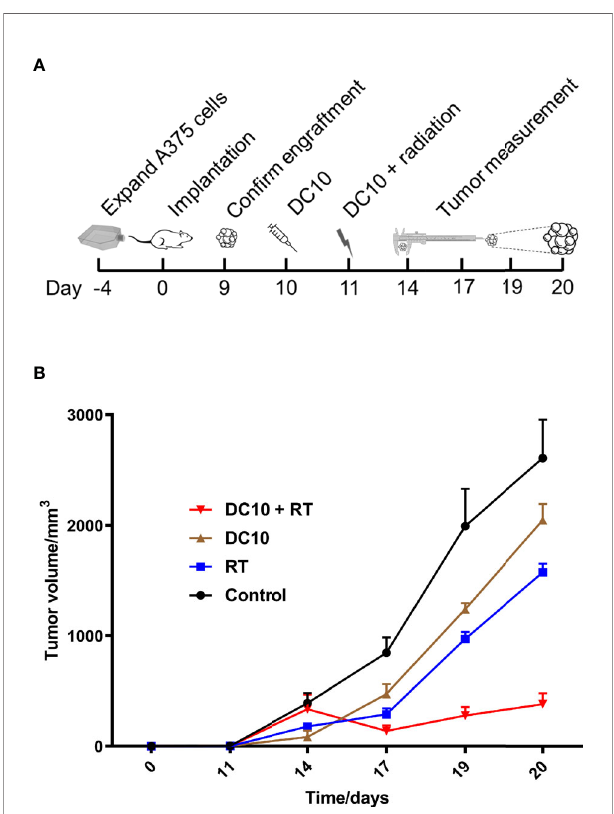
FIGURE 6 | DC10 interacts synergistically with radiotherapy to suppress growth of A375 melanoma xenografts in NOD-SCID mice. (A) Overview with timeline for the in vivo experiment. (B) Growth curves of A375 fl ank tumors for the different treatment groups, Ctrl: Control (n=6), DC10: DC10 treatment (n=5), RT: Radiotherapy (n=6) and DC10 + RT: Combination treatment